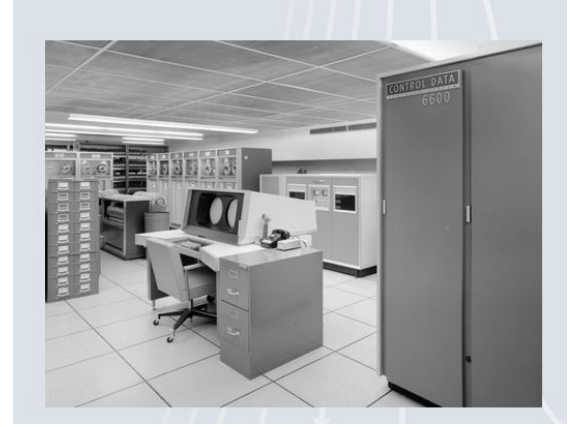
Figure 4. CDC 6600 (©UCAR).